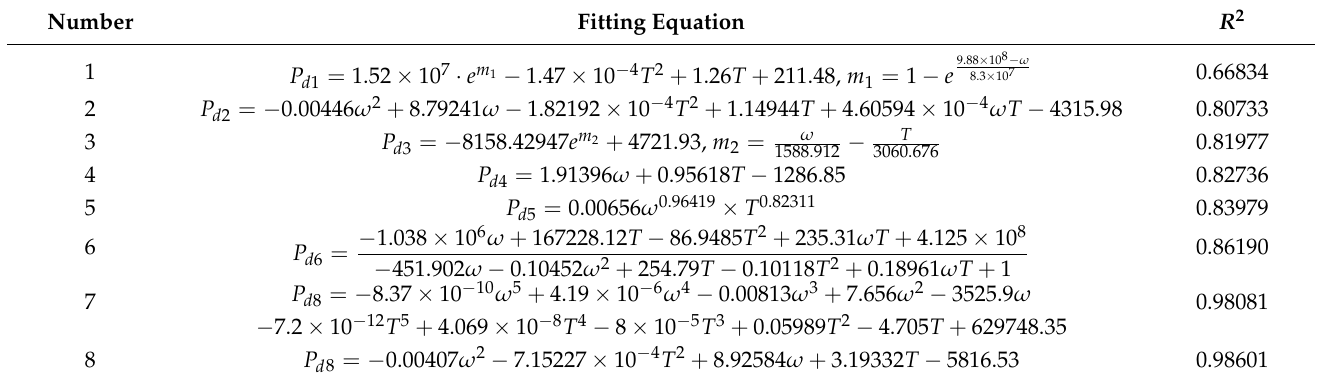
Table 4. Binary fitting equations of balloon yarn tension of the direct-twisting